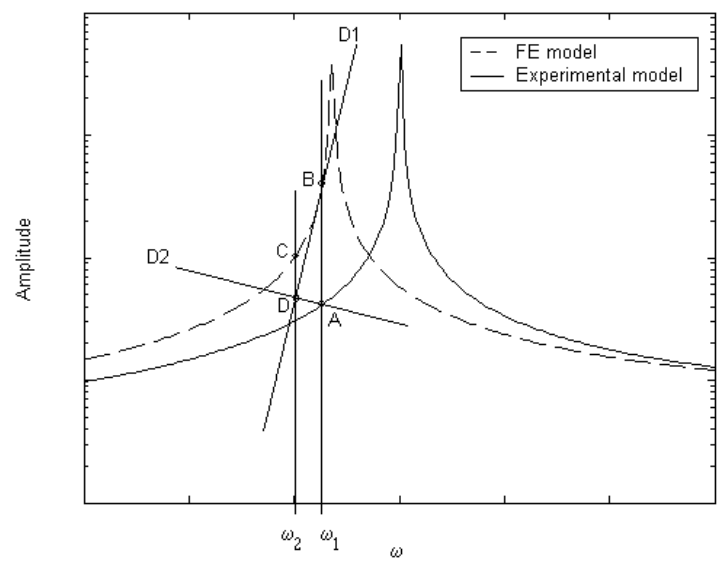
Fig. 2. Geometrical interpretation of the frequency